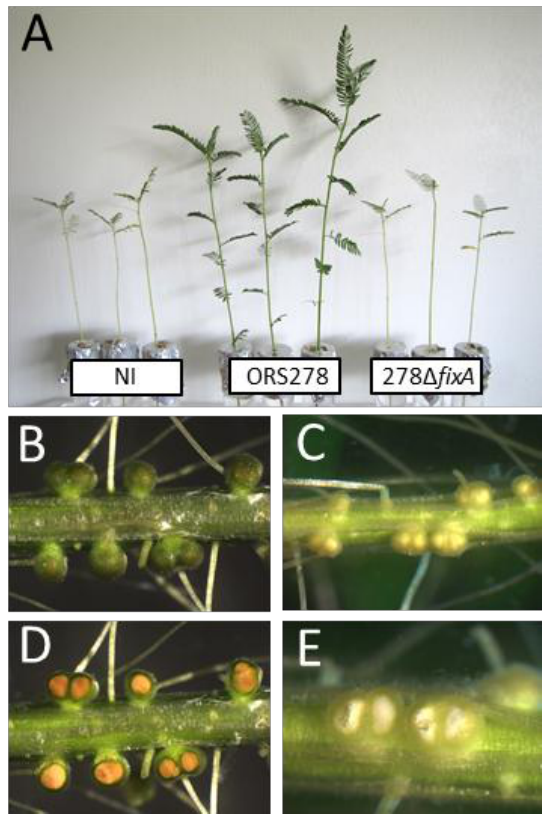
Figure 4. fixA locus is required for efficient symbiosis. ( A ) Aerial part of 14 day old plants inoculated with the indicated strain or not inoculated (NI); ( B ) and ( C ) are nodulated root systems of plant inoculated with WT and fixA :: pVO155 , respectively; ( D ) and ( E ) show root systems of plant inoculated with WT and fixA :: pVO155 on which nodules have been